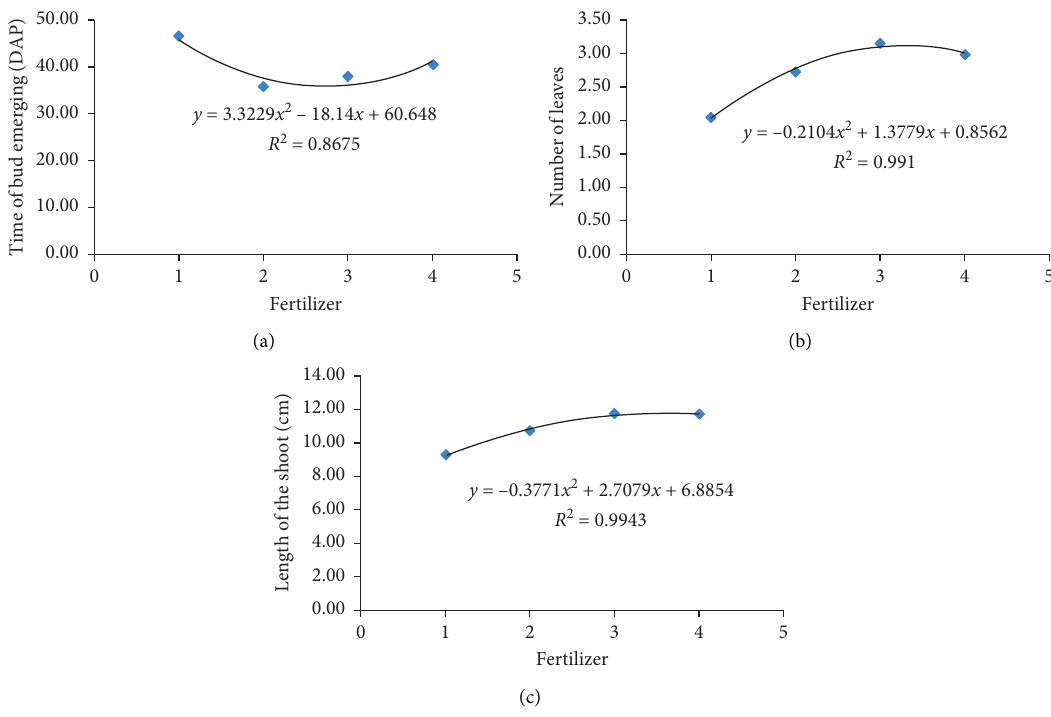
Figure 5: Regression analysis between foliar fertilizer application and time of bud emerging, number of leaves, and length of the shoot on pepper seedlings after 8 weeks of